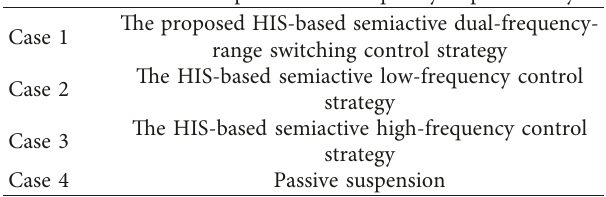
Figure 14: Proposed HIS-based semiactive dual-frequency-range switching control system schedule. Table 6: Four cases of suspensions for frequency response